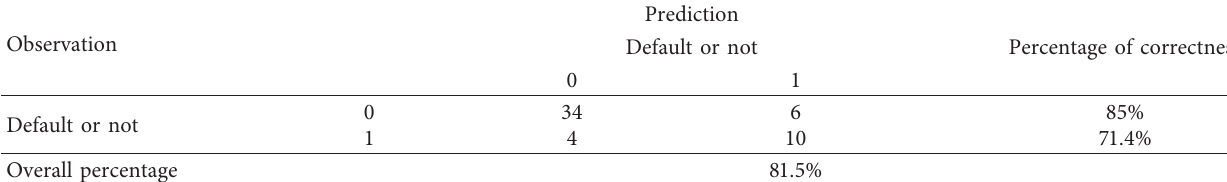
Table 6: Classification